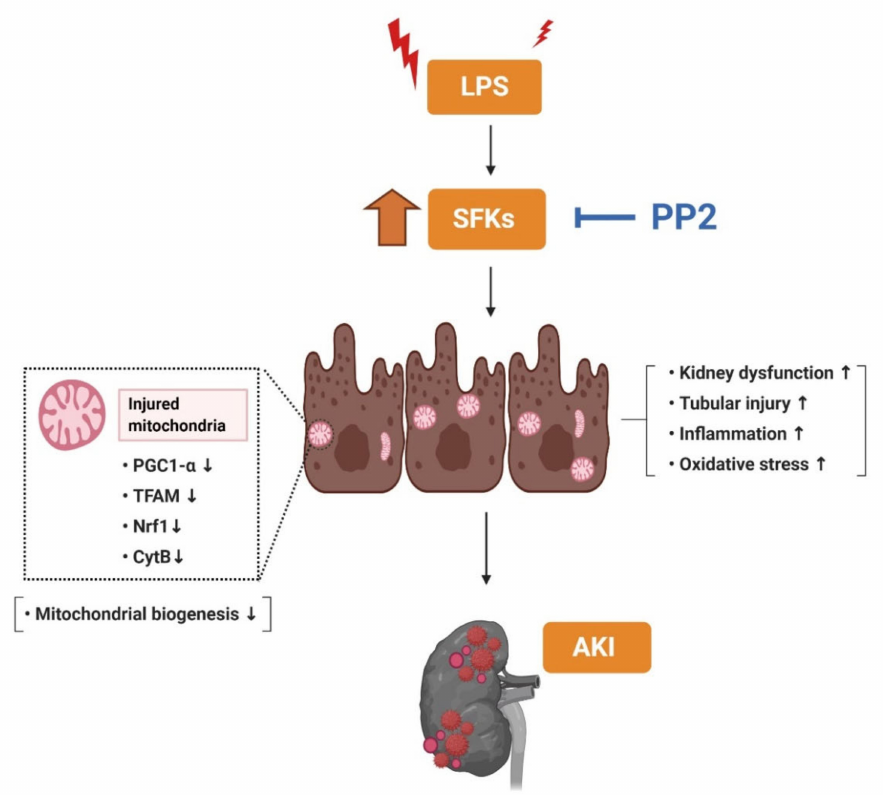
Figure 8. Schematic diagram illustrating that SFK activation a ff ects mitochondrial biogenesis in LPS-induced AKI mice. The SFK inhibitor, PP2, suppressed inflammation and oxidative stress and improved mitochondrial biogenesis in the LPS-induced AKI